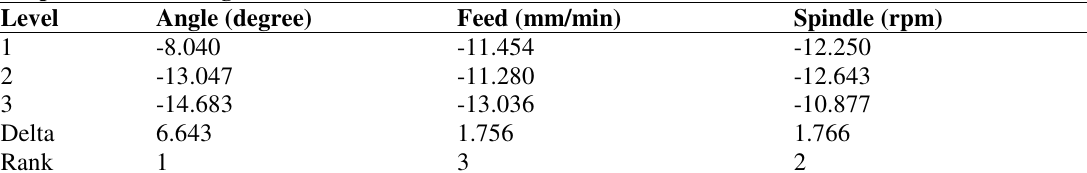
Response table for signal to noise ratios for brass.